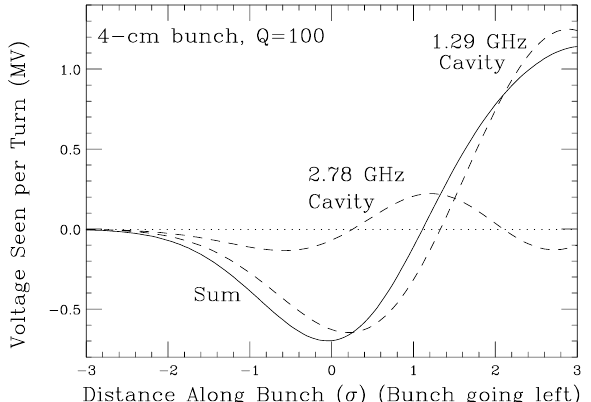
FIG. 9. Beamloading voltages seen by particles in the 4- cm bunch as they traverse the wake-potential compensating cavities. The particles are at a distance behind the bunch center in units of rms bunch length.